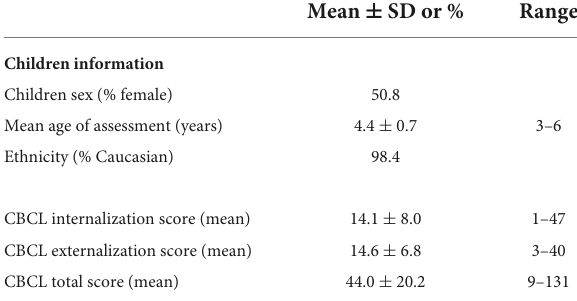
TABLE 1 Descriptive information ( N =